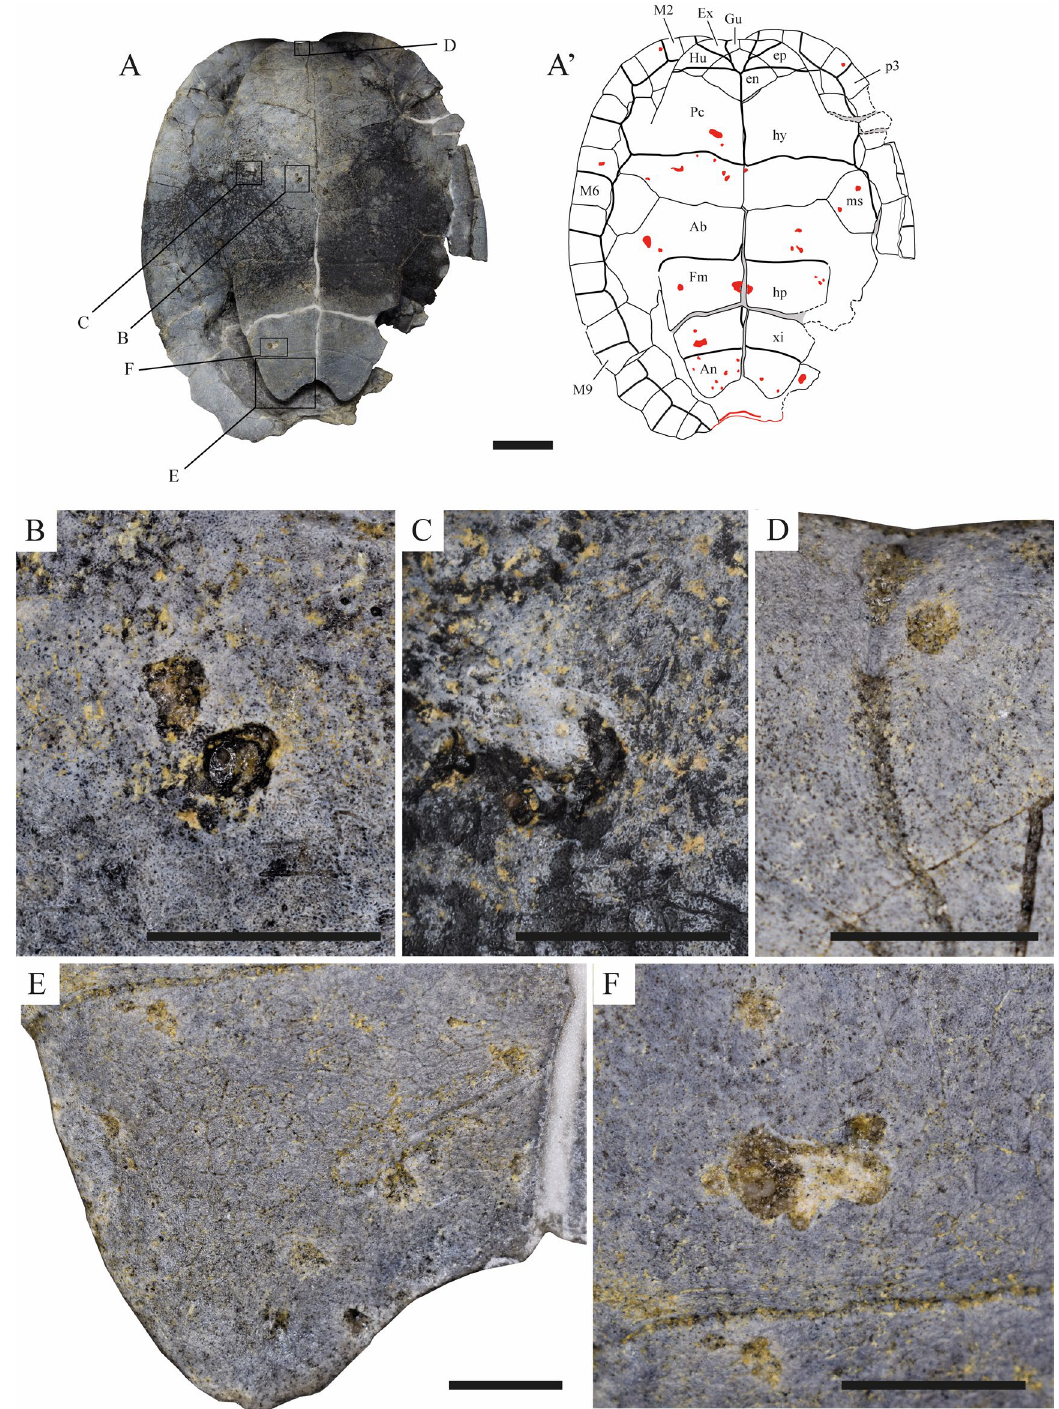
Figure 2. STUS 14024, anomalous plastron of a Neochelys sp. (Pleurodira, Podocnemididae) from the middle Eocene (Lutetian) of El Tejar fossil site, at Corrales del Vino (Zamora, Spain). ( A , A’ ) dorsal view. ( B – F ) detail of some of the anomalies identified on the ventral surface of the plastron: pits ( B , D , E ) and grooves ( C , F ). Scale bars equal 5 cm in ( A , A’ ), and 1 cm in ( B – F ). Abbreviations for the plates (in lowercase and normal type): ent, entoplastron; ep, epiplastron; hp, hypoplastron; hy, hyoplastron; ms, mesoplastron; p, peripheral; xi, xiphiplastron. Abbreviations for the scutes (in uppercase and in bold type): Ab, abdominal; An, anal; Ex, extragular; Fe, femoral; Gu, gular; Hu, humeral; M, marginal; Pc, pectoral.